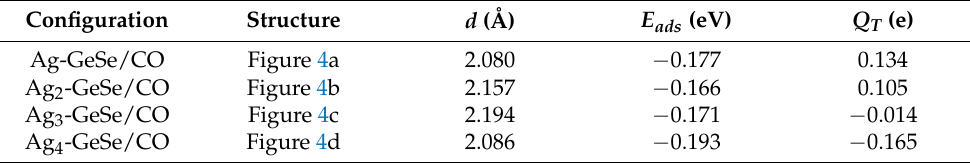
Table 1. Adsorption parameters of CO gas molecules on Ag n -GeSe. Configuration Structure Figure 5. TDOS and PDOS of gas molecules adsorption on Ag n -GeSe. ( a1 ) TDOS of CO on Ag modified GeSe ( b1 ) TDOS of CO on Ag 2 modified GeSe ( c1 ) TDOS of CO on Ag 3 modified GeSe ( d1 ) TDOS of CO on Ag 4 modified GeSe; ( a2 – d2 ) are PDOS of the corresponding subgraph.